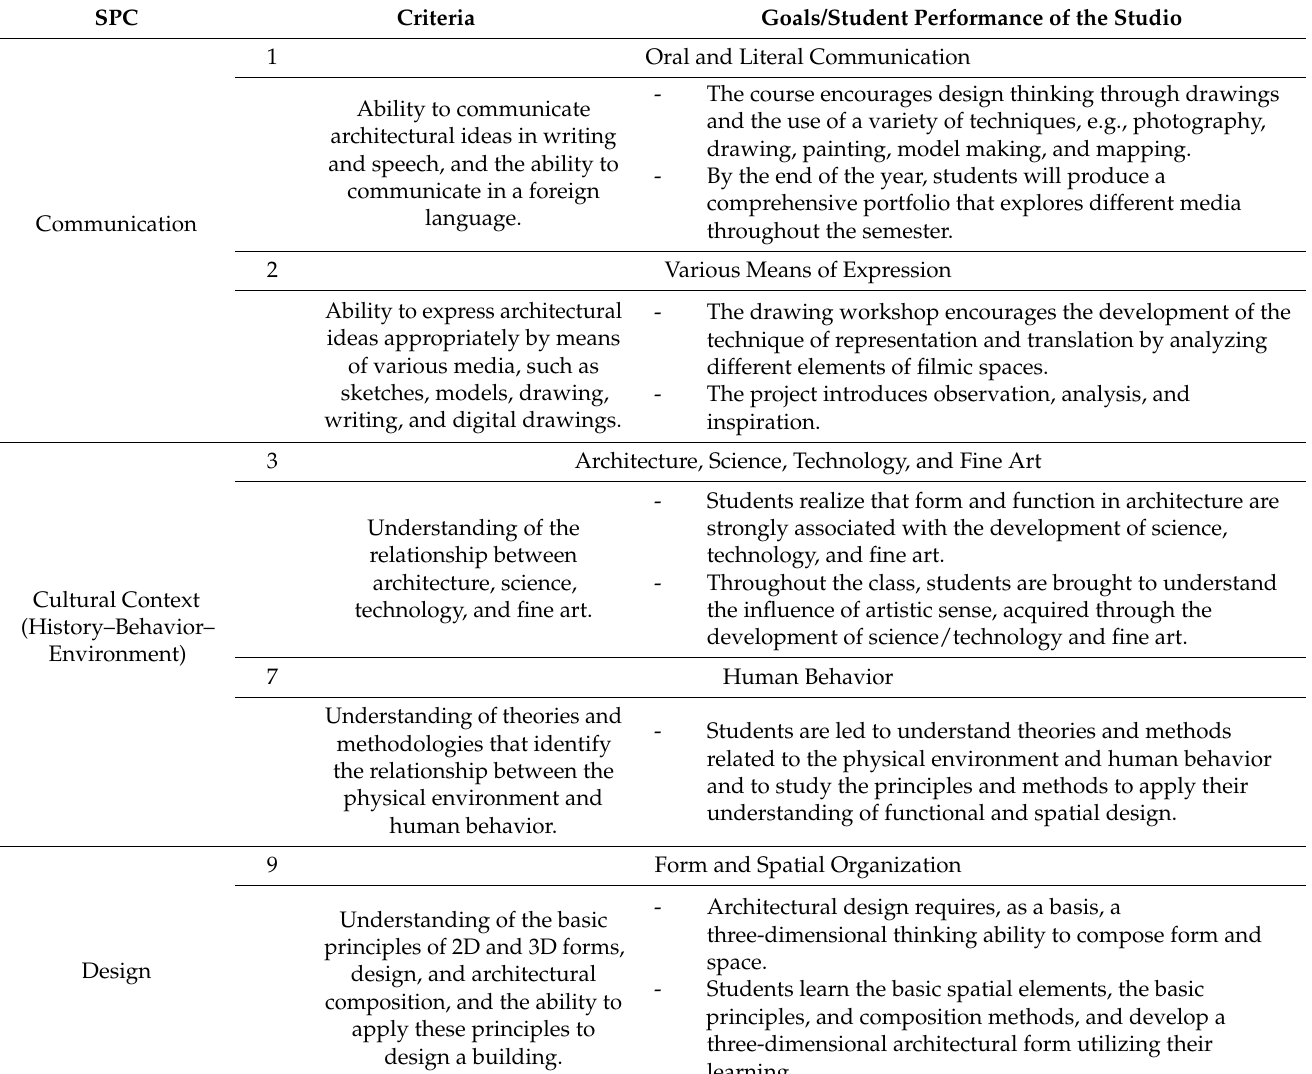
Table 1. Student performance criteria (SPC)